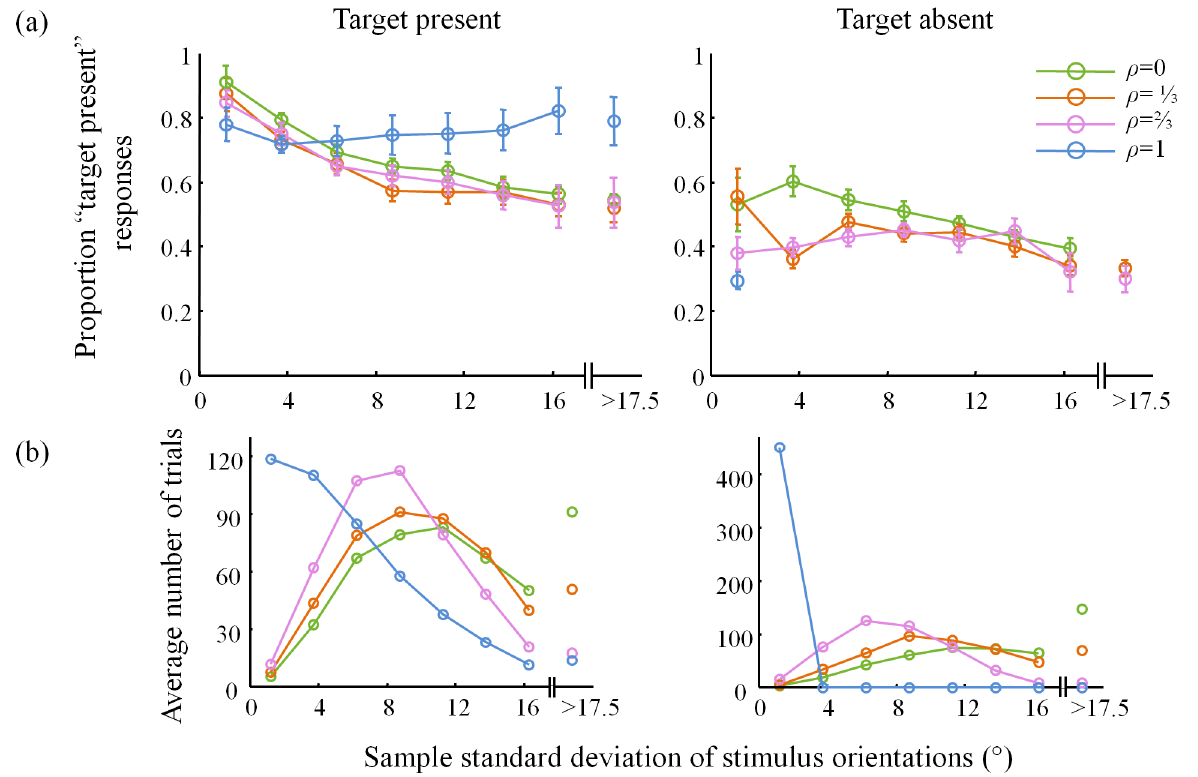
Fig 3. Psychometric curves 2. (a) Proportion “ target present ” responses and (b) number of trials as a function of standard deviation of the distractor set coefficient, averaged across subjects. Bin size was 2.5°, except that all trials with sample standard deviation greater than 17.5° are collected in the last bin. The plots in (b) are entirely determined by the stimuli, not by the subject responses; they serve to emphasize that the points in the plots in (a) were computed on widely differing numbers of trials.